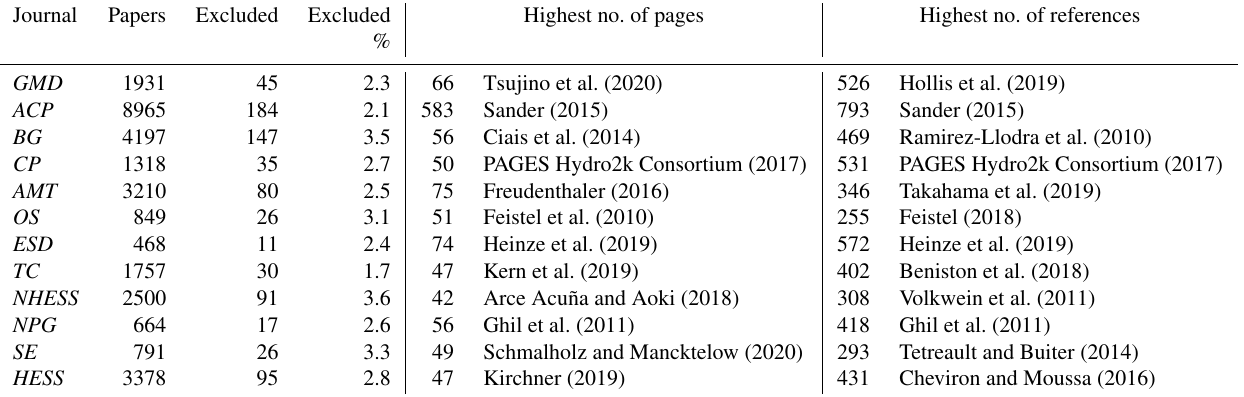
Table 1. Summary of journal characteristics. The number of papers analysed in each journal is listed, as well as the number of papers excluded (also expressed as a fraction) as outliers. The papers with the highest number of pages and the highest number of references are also listed for each journal.